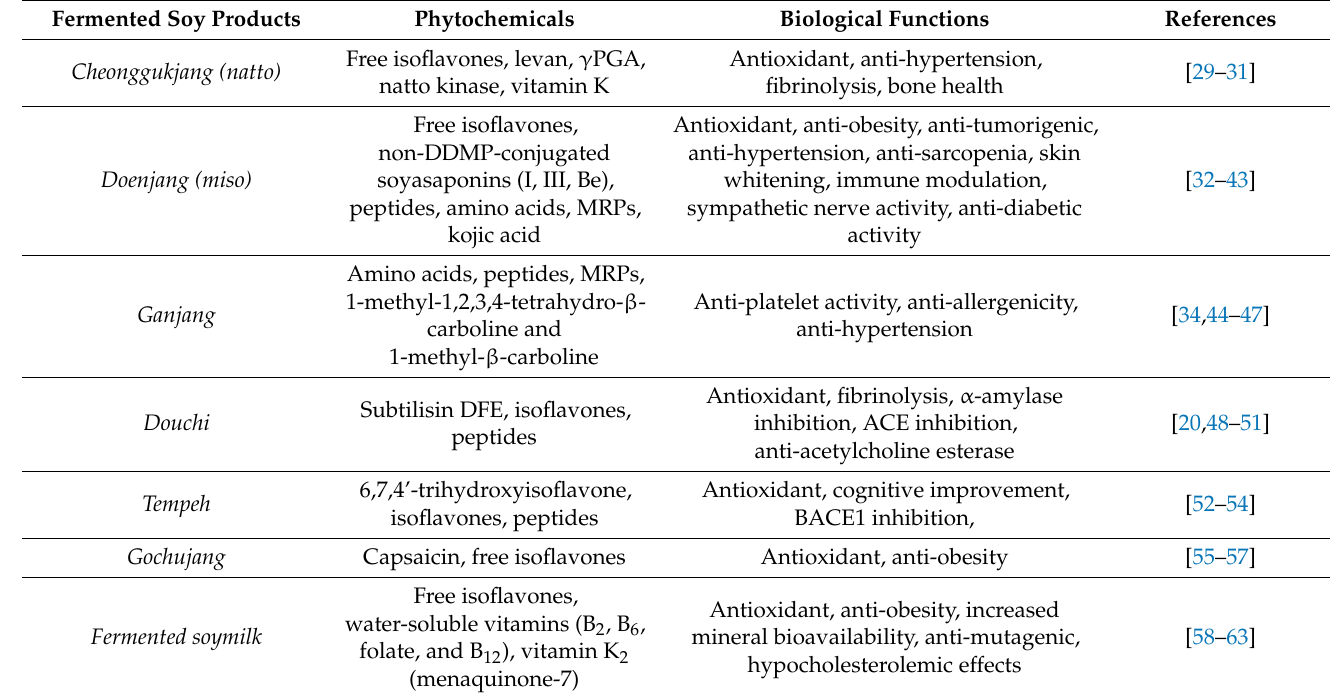
Table 1. Fermented soy products and